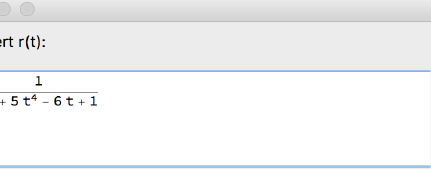
Figure 53. Part of the structure of the [ASPPlusPMinus] algorithm corresponding to Option 1 to input r .